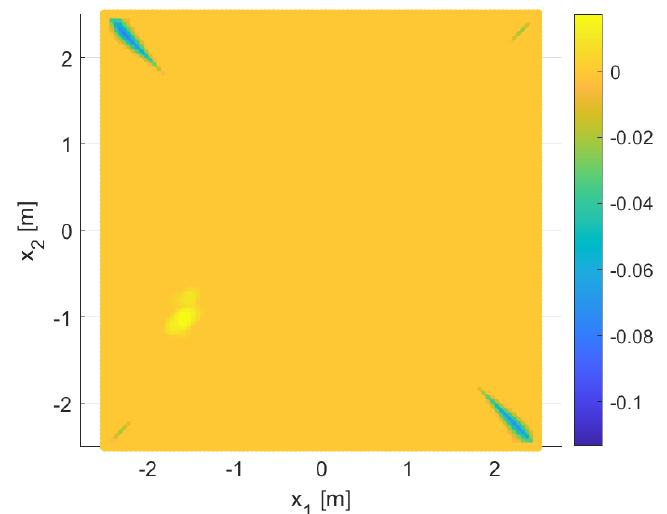
Figure 11. Colormap of g with respect to x 1 and x 2 . Yellow points represent regions of the domain for which the membrane is above the extrados. Blue points on the diagonal of the domain represent regions of the domain for which the membrane shape is below the intrados.